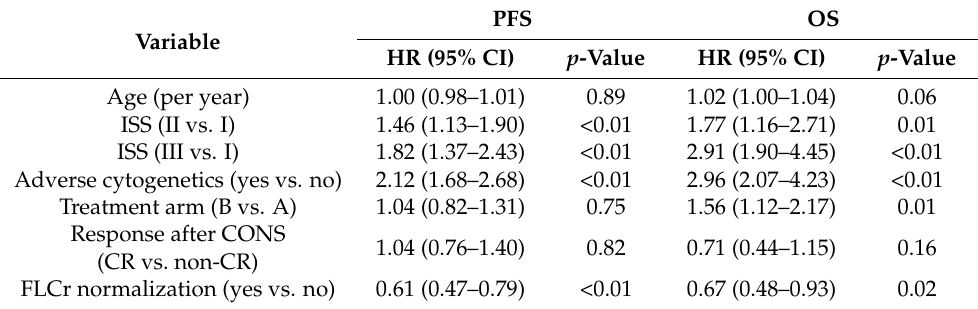
Table 2. Impact of achieved FLCr normalization until the start of maintenance at the latest on PFS and OS. The results of the time-dependent multivariate Cox regression